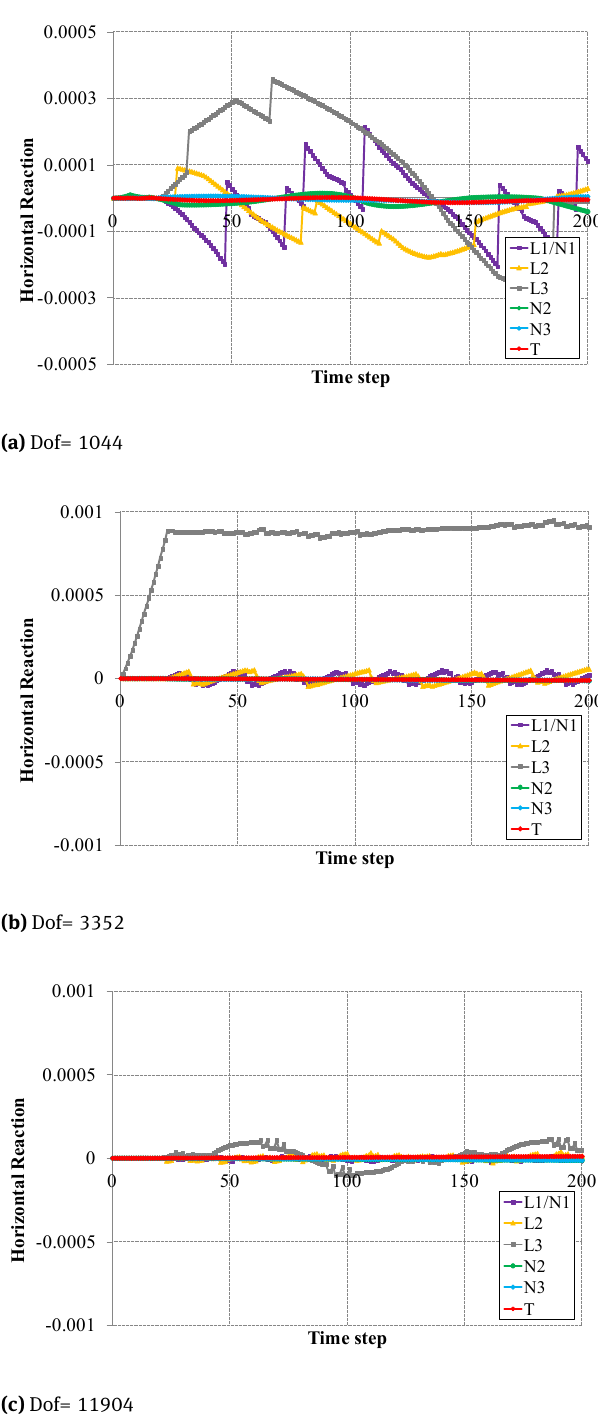
Figure 12: Ironing problem: horizontal reaction-time